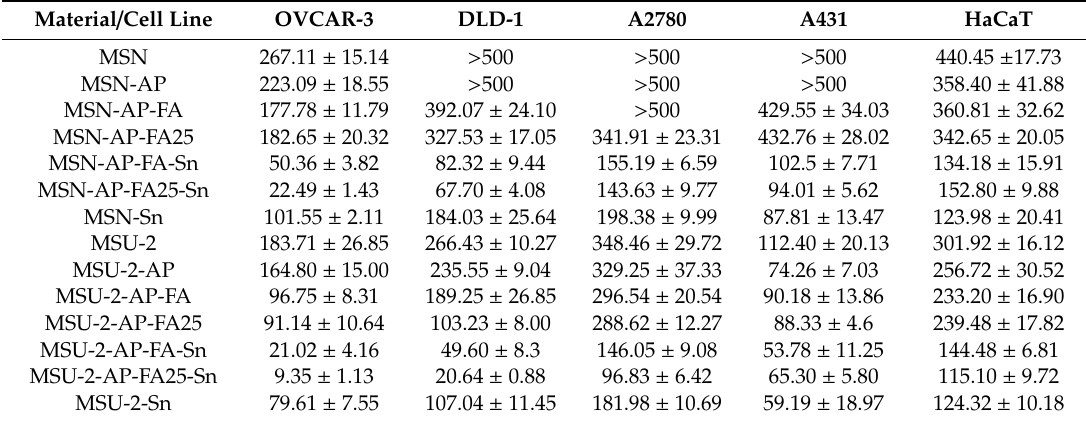
Table 3. The half maximal inhibitory concentrations (IC 50 ) of the MSN and MSU-2 materials; IC 50 were derived from the nonlinear dose–response curves, in the 95% confidence interval; values expressed as mean ± standard deviation, in µ g /